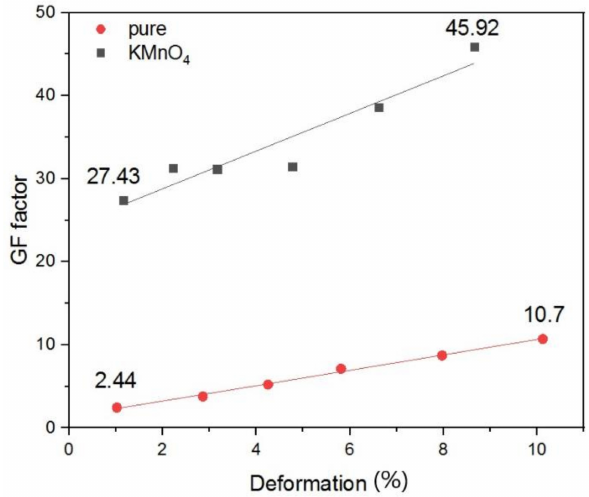
Figure 6. Dependence of gauge factor (GF) with increasing deformation for MWCNTs (pure) and oxidized MWCNTs (KMnO 4 ) sensors.